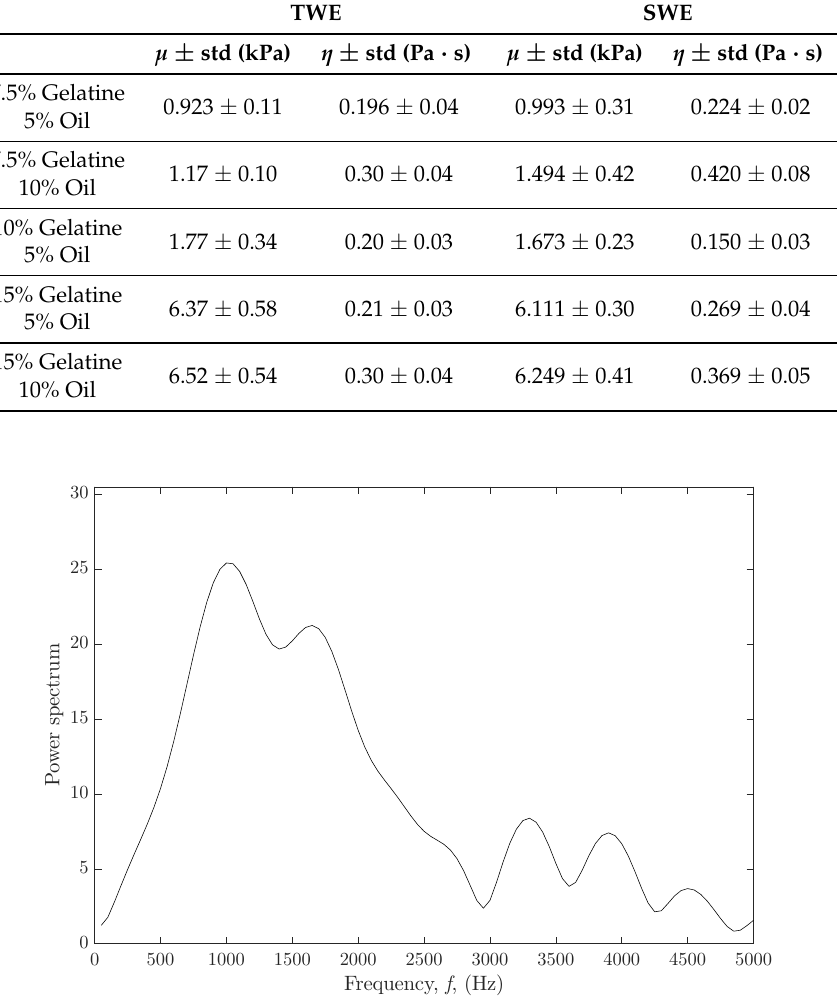
Figure 10. Power spectrum of the shear wave tracked for 7.5% gelatine and 10% oil batch (data acquired from